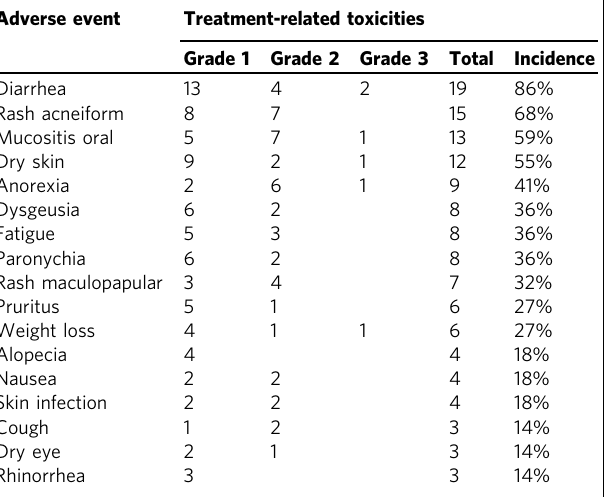
Table 3 Grade 1 – 3 treatment-related adverse events. Adverse event Treatment-related